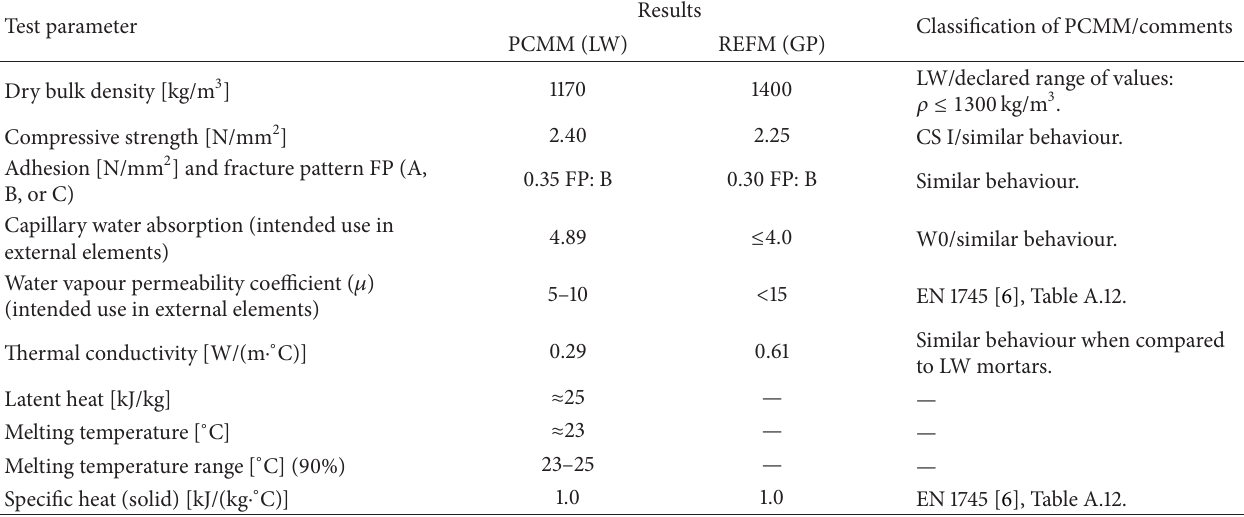
Table 3: Results of the test performed to the composite mortar with formulation L (PCMM) and comparison to reference mortars